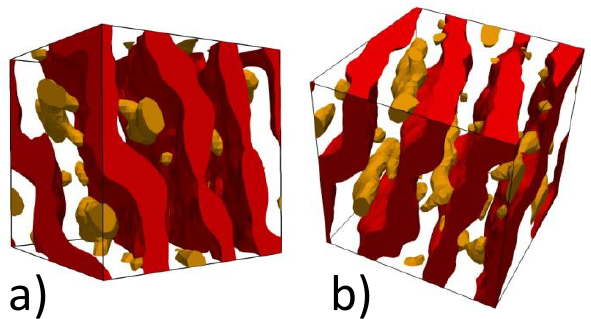
Figure 6. Morphology of the domains formed by longer (red) and shorter (brown) rigid A blocks of the A 10 B 10 A 4 copolymer for a AB = 50, a AA = a BB = 25. Snapshots ( a , b ) are taken from different viewpoints.